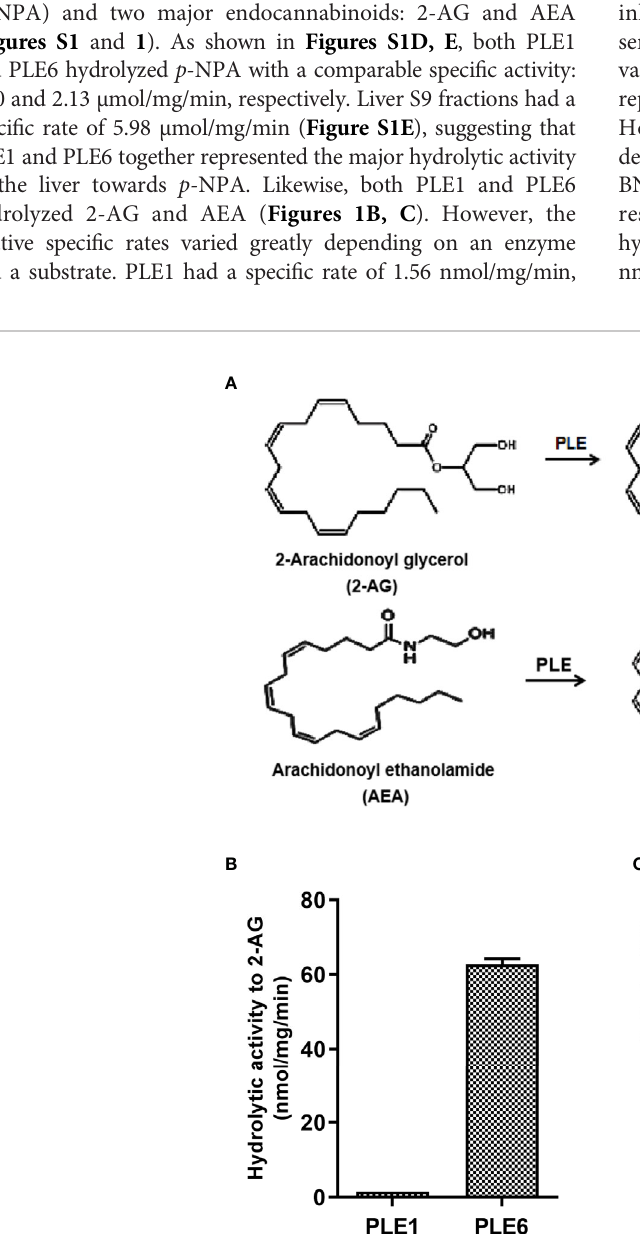
FIGURE 1 | Hydrolysis of 2-AG and AEA by puri fi ed PLE1 and PLE6. (A) Reaction diagram for 2-AG and AEA hydrolysis. (B) Hydrolysis of 2-AG. (C) Hydrolysis of AEA. Substrates (2-AG or AEA) at 200 µM was prepared in Tris-HCl buffer (50 mM, pH 7.4) and then mixed with puri fi ed PLE1 or PLE6 (10 µg). After incubation for 10 min at 37°C, the reactions were terminated, and the formation of AA was monitored with LC-MS/MS. The data in Figures 1B and C are presented as the mean ± standard error of the mean (SEM) of 3 independent